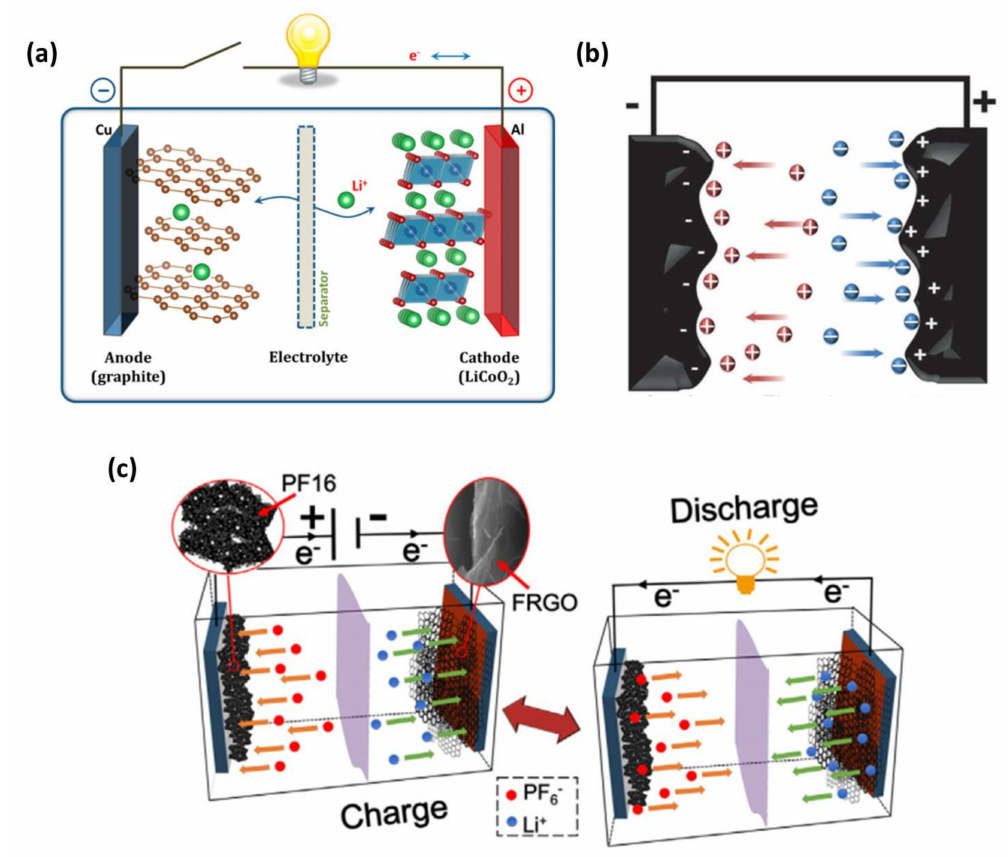
Figure 1. The schematic of the charge/discharge mechanisms of typical ( a ) LIBs, ( b ) EDLCs and ( c ) LICs. (( a ) Reprinted with permission from Ref. [19]. Copyright 2013 American Chemical Society. ( b ) Reprinted with permission from Ref. [22]. Copyright 2014 Wiley-VCH. ( c ) Reprinted with permission from Ref. [41]. Copyright 2015